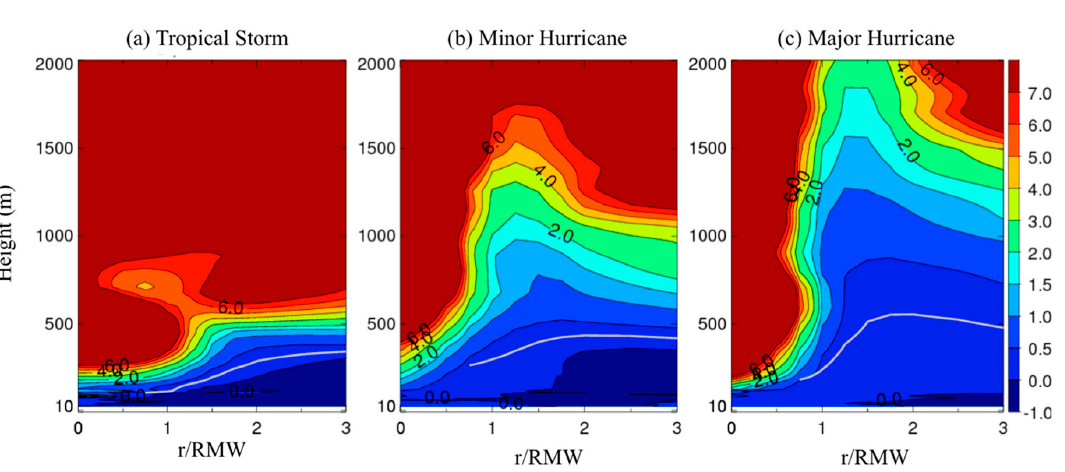
Figure 9. Composite analysis of the Richardson numbers as a function of altitude and normalized radius for ( a ) tropical storms, ( b ) minor hurricanes, and ( c ) major hurricanes. The gray line in each panel show the 0.25 contour.